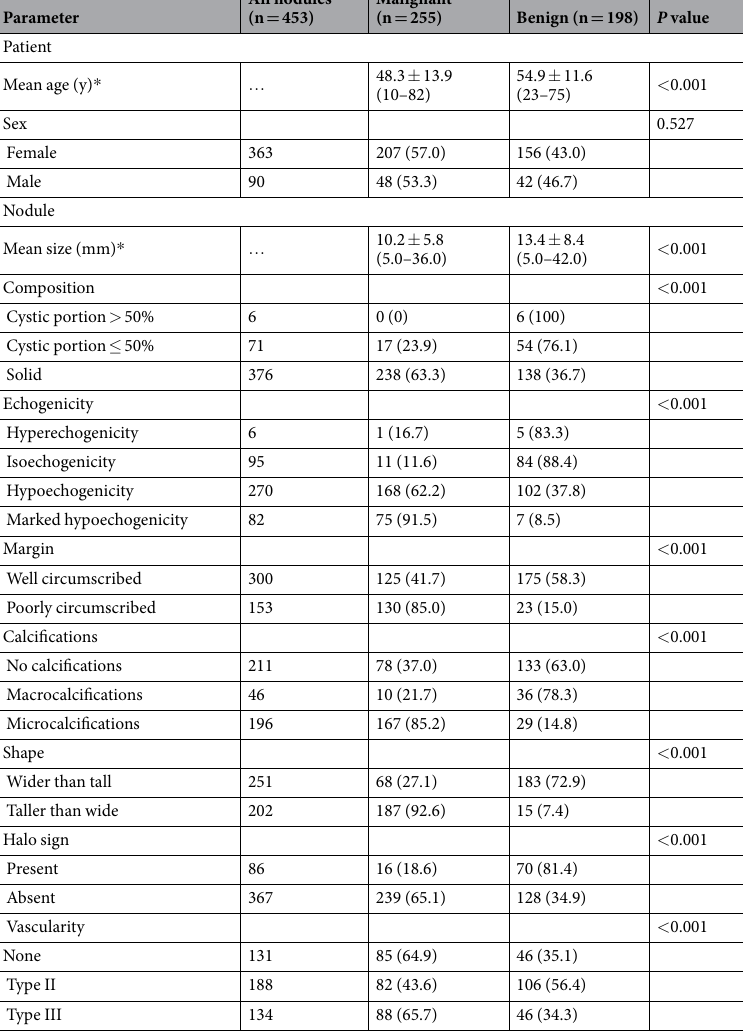
Table 2. Basic demographic characteristics and conventional US features in diagnosing all thyroid nodules according to malignant and benignity. * Indicates means ± standard deviations. Data are ranges, otherwise are percentages in the parentheses. Type II = predominant pattern of peripheral blood flow; Type III = predominant pattern of internal blood flow.